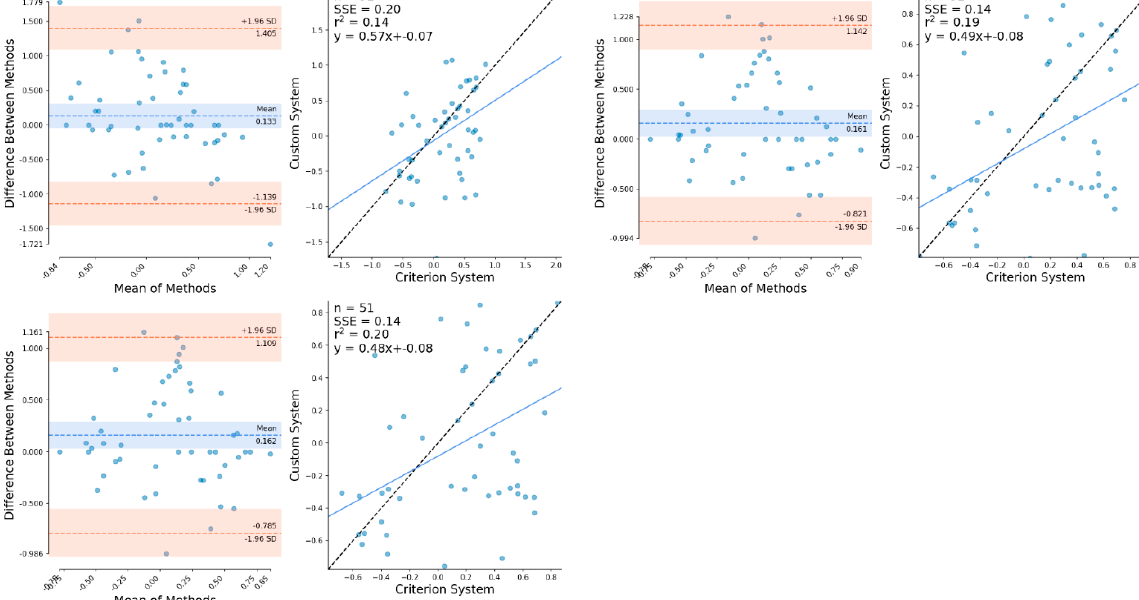
Figure A9. Bland-Altman and linear regression plots demonstrating the differences between OpenPose unfiltered (top-left), low-pass filtered (top-right) and Kalman smoothed (lower-left) CoM vertical velocity against marker-based CoM vertical velocity during sprinting.